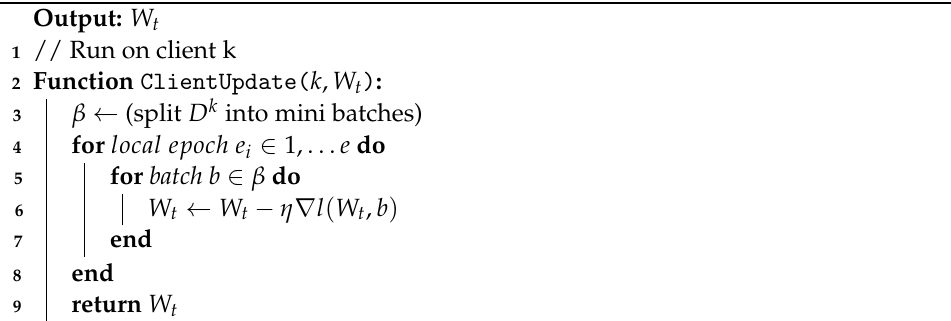
Algorithm 2: Local client update, k : Number of clients, D k : Client k local dataset, e : Number of local epochs, and η is the learning